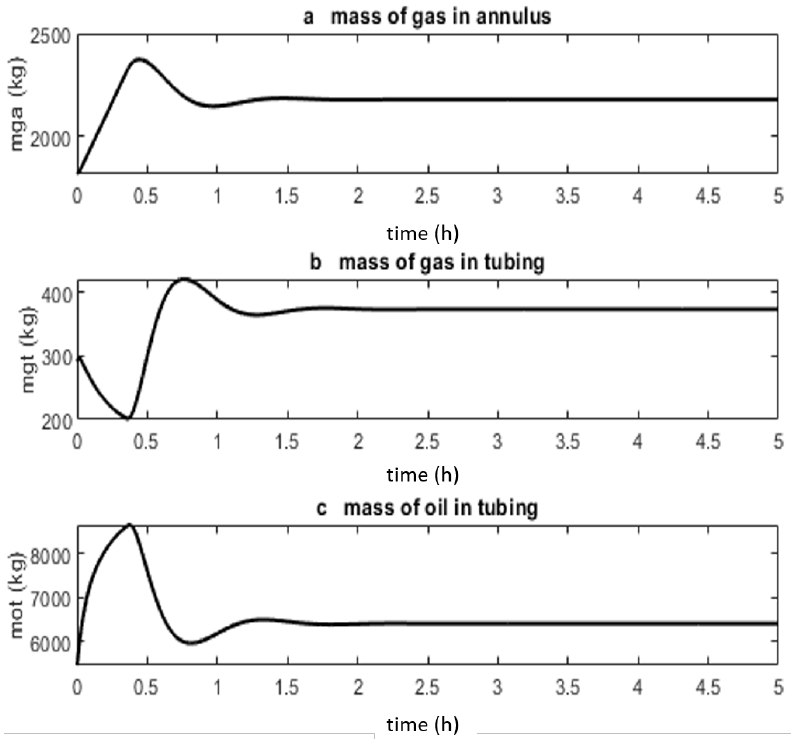
Figure 2. States of a gas-lifted system for u = 0.65 in a stable mode. These states are the mass of the gas in annulus x 1 , mass of the gas in tubing x 2 and mass of the oil in tubing x 3 . All three states are positive, including other algebraic variables of the system. The states converged to fixed values as there was no oscillation.